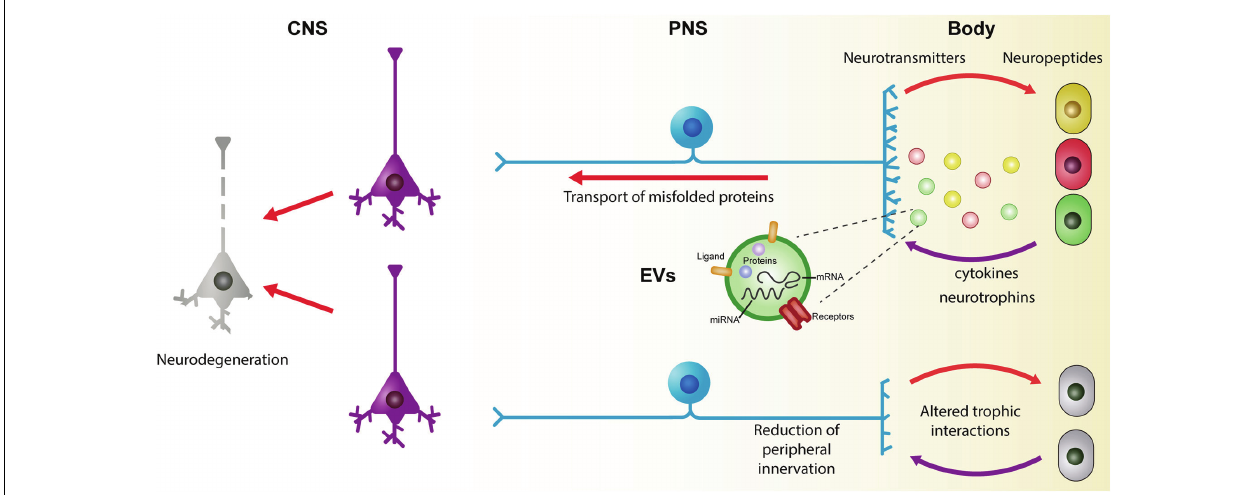
FIGURE 2 | The role of trophic interactions between the brain and the body in the development of neurodegenerative diseases. Under physiologic conditions, there is a continuous exchange of information between neurons and their targets. Neurons control several aspects of the cells they innervate by the release of neuropeptides and neurotransmitters. Reciprocally, peripheral cells modulate neuronal physiology by the release of several molecules including neurotrophins and cytokines. Recently, extracellular vesicles (EVs) have been considered as key players in the development and progression of chronic and degenerative diseases. An alteration of the homeostatic state of peripheral cells is reflected on the molecular cargo of EVs which, in turn, can affect the functioning of the neurons. Common to several chronic and neurodegenerative diseases, there is a reduction of peripheral innervation which leads to a disturbance of the trophic relation between the body and the central nervous system. A continuous alteration of these interactions during maturity of individuals may underlie some of the early events that reflect on neuronal death during aging. CNS, central nervous system; EVs, extracellular vesicles; PNS, peripheral nervous